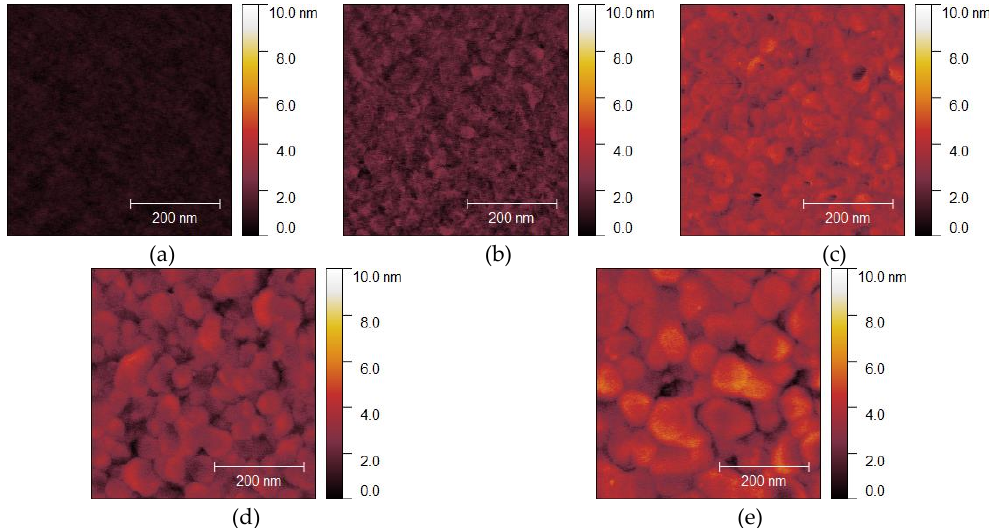
Figure 10. Typical AFM images of Au thin films deposited on glass wafers: ( a ) before deposition; ( b )– ( e ) after deposition of films with thicknesses of 15, 50, 100, 300 nm, respectively.